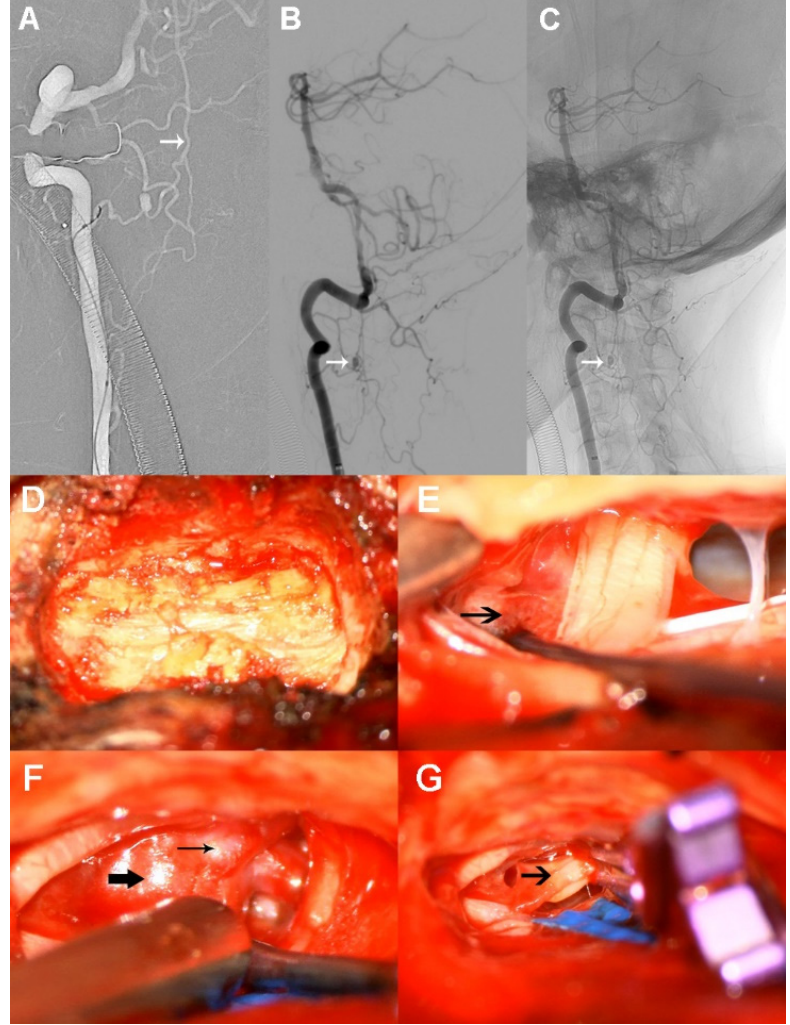
Figure 3. Therapy processes in the hybrid operating room. ( A ) The tip of the microcatheter is successfully guided into the proximal parent artery. ( B , C ) As the arrows show, the aneurysm is located at the lower border of C2 centrum. ( D ) Right-side laminectomy. ( E ) Arrow shows dense blood clots around the ruptured aneurysm. ( F ) Parent artery (thin arrow) and aneurysm (thick arrow) are shown. ( G ) The ruptured aneurysm is completely clipped, leaving the sac wall to collapse (arrow). A scheduled CT was performed on the first postoperative day. As shown in Figure 4A–C, there was only a slight pneumocephalus, but no cerebral hemorrhage or infarction was observed, and the clip was well positioned. Furthermore, the neurological status of the pa- tient remained basically unchanged for the first two days after the operation. However, the patient experienced a decline in consciousness at 3 days postoperatively. A head CTA con- firmed aggravating cerebral vasospasm, especially bilateral VA and middle cerebral artery, and cortical hypodense changes were observed in the right cerebellum and left temporal cortex (Figure 4D–F). Therefore, we increased the strength of the anti-vasospasm treatment and performed a lumbar puncture to facilitate the drainage of bloody cerebrospinal fluid. In addition, anticoagulant therapy was also used to prevent venous thrombosis. Unexpectedly, the patient suddenly developed dyspnea, with severe oxygen desaturation and low blood pressure 7 days later. After emergency tracheal intubation and ventilator support, the patient’s vital signs gradually stabilized. However, over several hours, a sudden cardiac arrest occurred. Finally, her family refused further treatment and she died less than 1 day after leaving